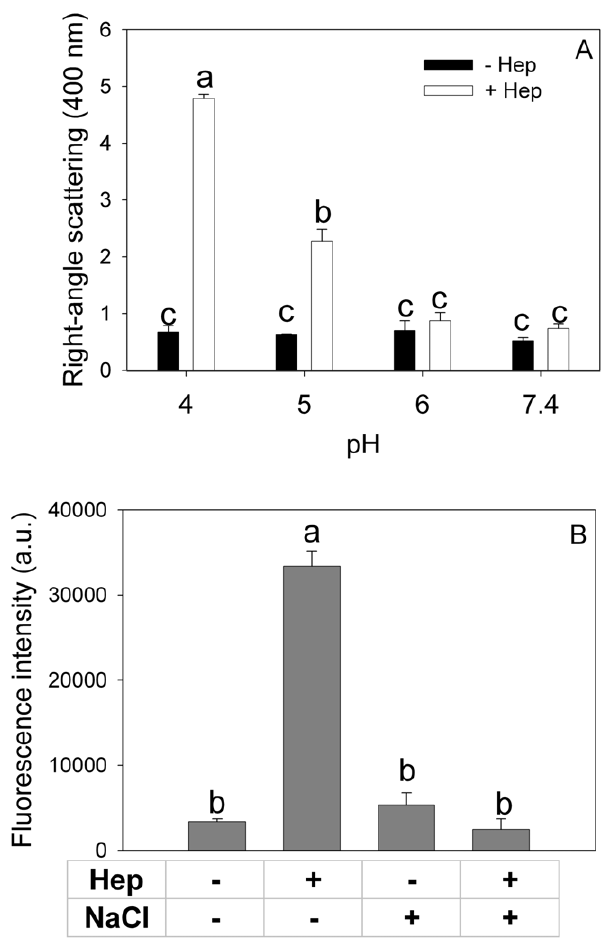
Figure 5. Binding to heparin as a function of pH and salt concentration. (A) Light scattering signal (at 400 nm) of 0.05 mg/mL apoA-I incubated for 2 h at different pH values in the absence (black bars) or in the presence (white bars) of heparin (2:1 molar ratio heparin:protein). (B) ThT binding to heparin-apoA-I complex at pH 5.0 in the presence or absence of 500 mM ClNa. ThT fluorescence was measured as described in Figure 3. Bars correspond to means 6 SE. Bars denoted by different letters differ significantly at p , 0.05.